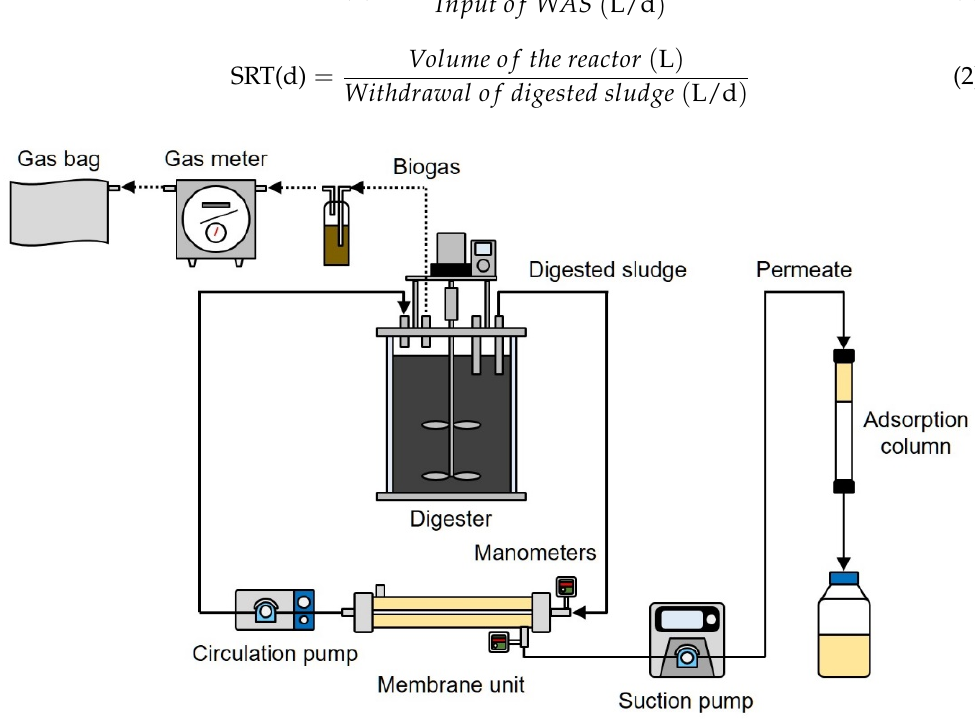
Figure 1. Schematic diagram of the reactor.